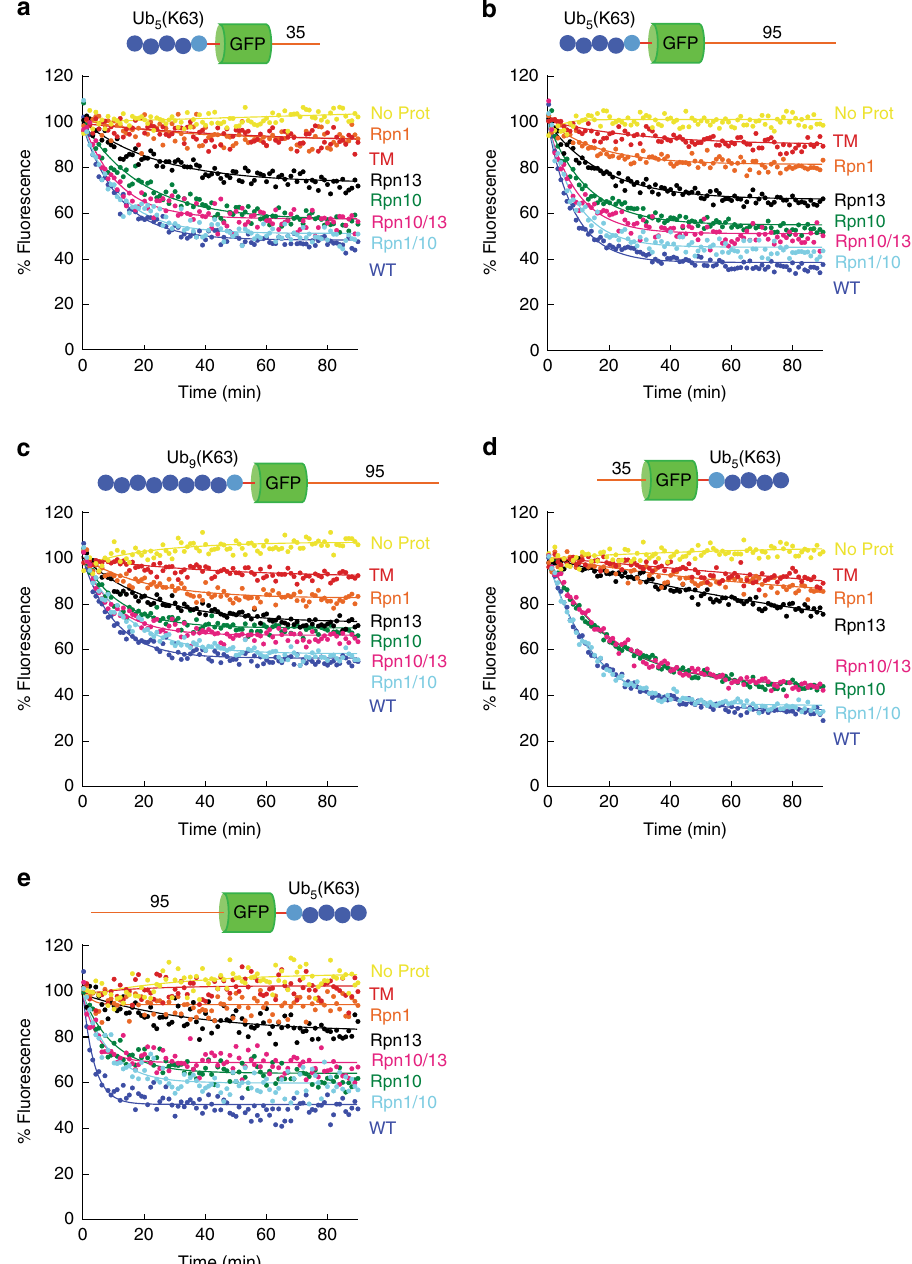
Fig. 3 Degradation of substrates with K63-linked polyubiquitin chains. Degradation of substrate proteins with K63-linked ubiquitin chains by the indicated proteasome mutants was followed under single-turnover conditions (5 nM substrate, 25 nM proteasome) in the presence of 1 mM ATP at 30 °C. The graphs show substrate fl uorescence as a percentage of the initial fl uorescence as a function of time in minutes. Proteasome types are described in Supplementary Table 1 (TM triple mutant proteasome). Each panel shows the degradation of particular substrates, and as follows: a Ub 5